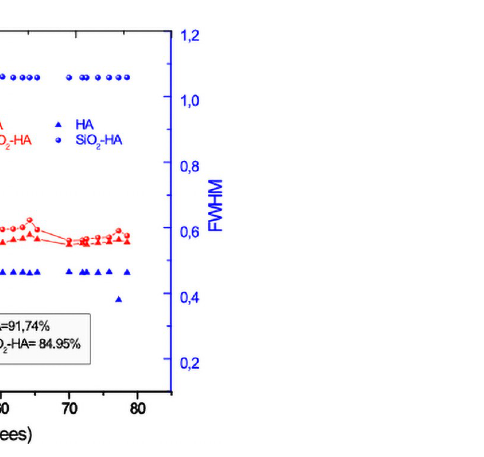
Fig 5. Plot of the peak area and FWHM of the samples HA and SiO 2 -HA.